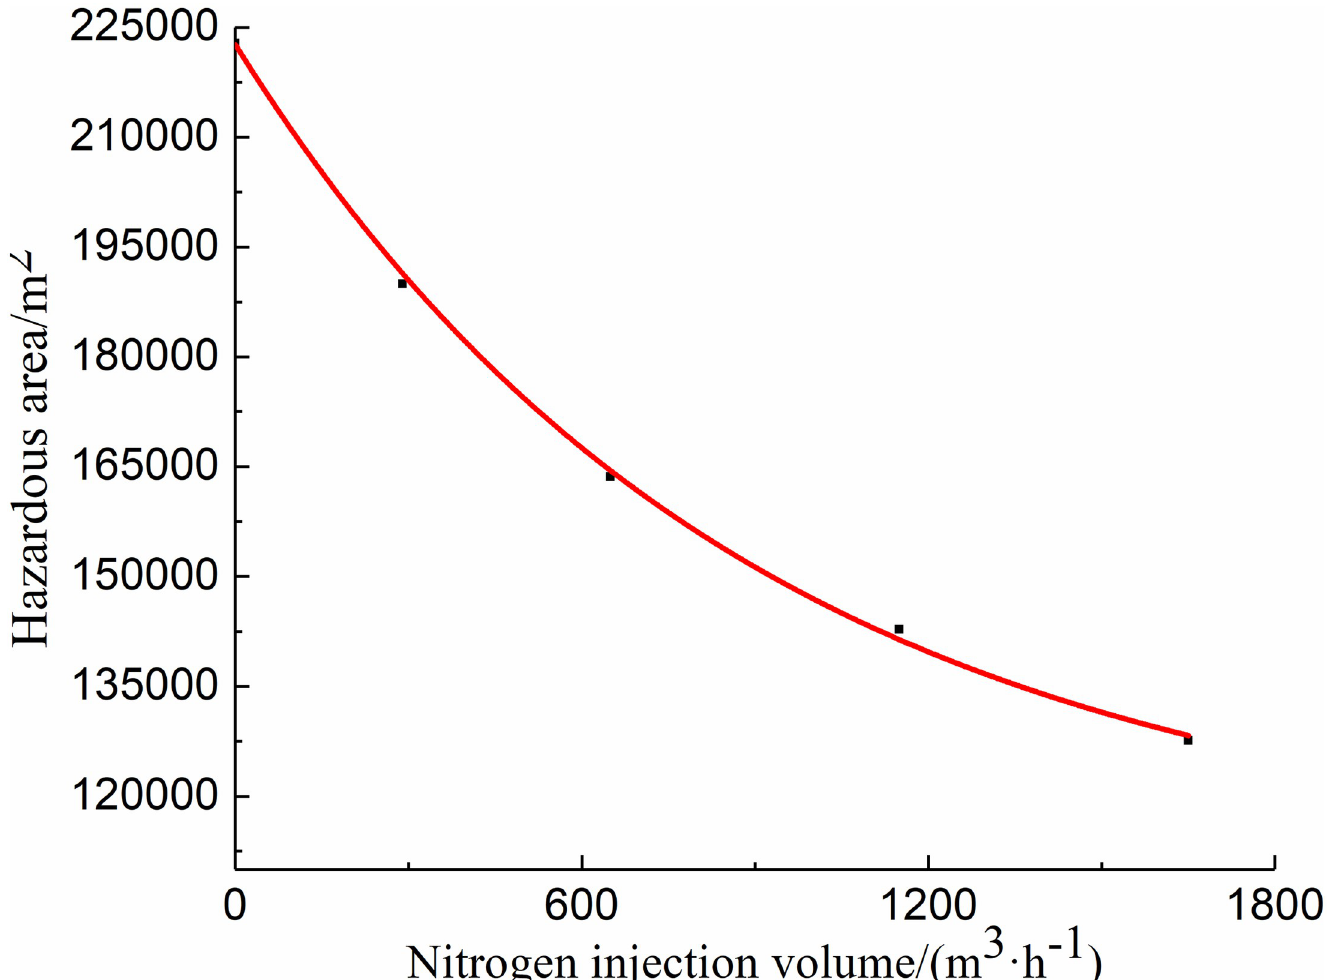
Fig 15. Nitrogen injection effect curve under different nitrogen injection